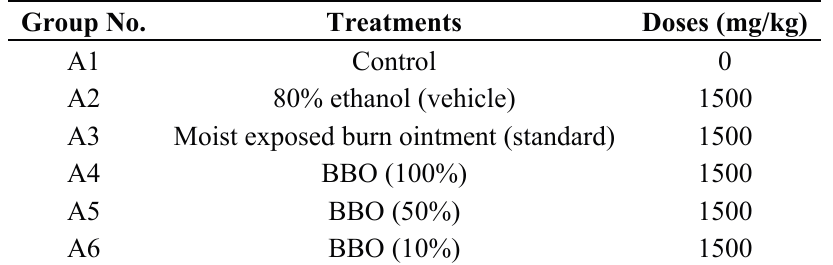
Table 1. Animal groups ( n = 24/group), treatments, doses and route of administration of different concentration or fractions of BBO